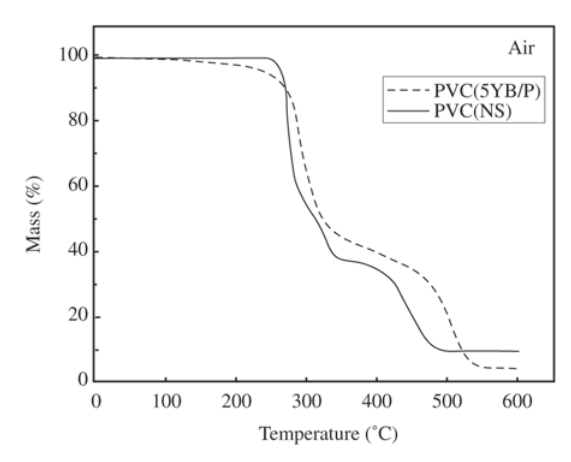
Figure 2 . Data of the thermogravimetric